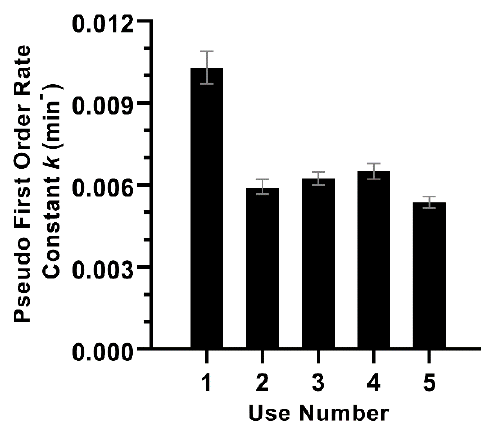
Figure 4. Reusability tests: pseudo first-order reaction rate constants for SMX experiments (i.e., the same coated disc was reused with 1 L of spiked water and 36 W UVA).